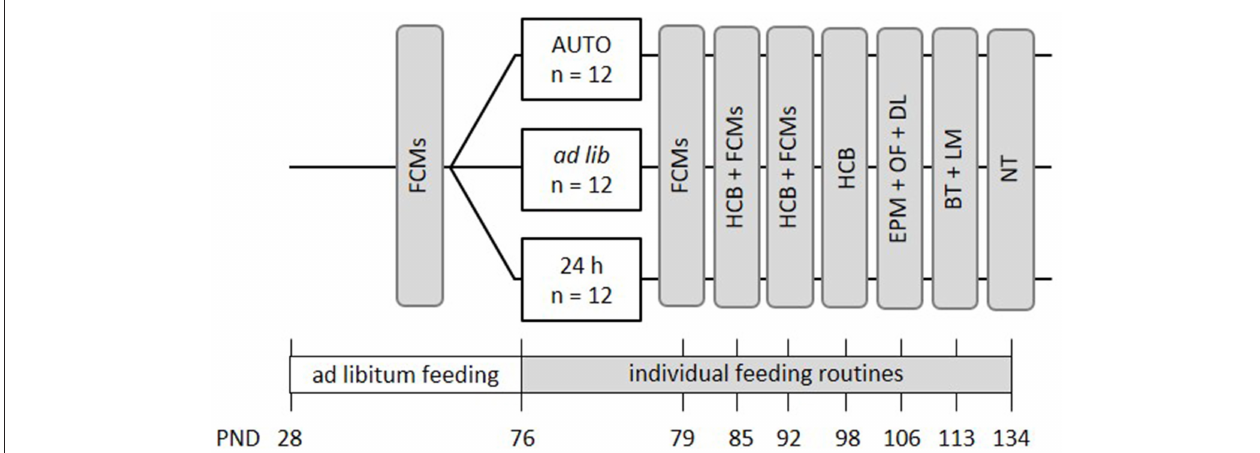
FIGURE 3 | Schematic timeline of experiment 2. From PND 76 on, the animals were subjected to individual feeding routines and either fed ad libitum ( ad lib ), according to the 24h schedule (24h) or the automated feeding routine (AUTO). They were kept to this diet for a total experimental time of 9 weeks. Effects on animal welfare were evaluated by home cage behavior observations (HCB), measurements of fecal corticosterone metabolites (FCMs) and different behavioral tests, including the Elevated Plus Maze Test (EPM), the Open Field Test (OF), the Dark-Light Test (DL), the Barrier Test (BT), the Labyrinth-Maze Test (LM), and the Nest Test (NT). All information on PNDs have an accuracy of ± 2